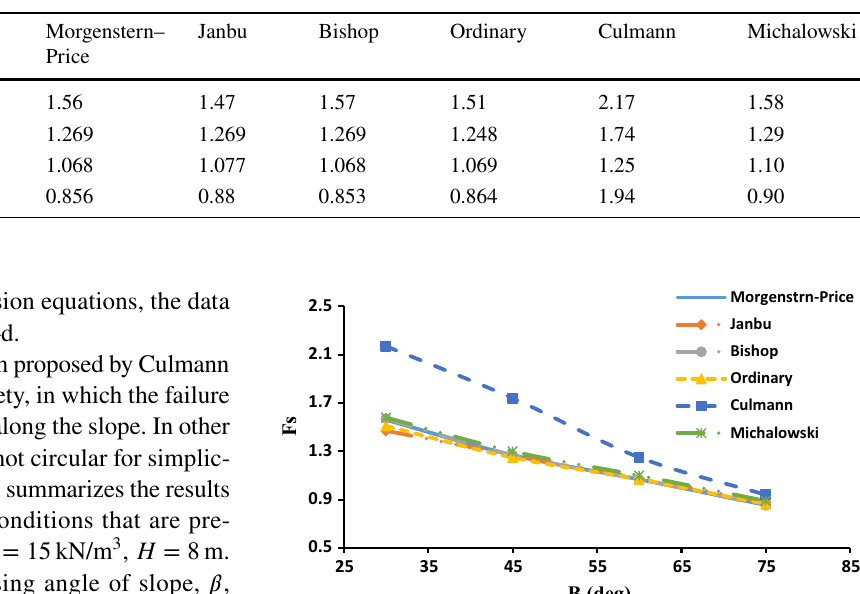
𝛾 = 15kN/m 3 , H = 8m